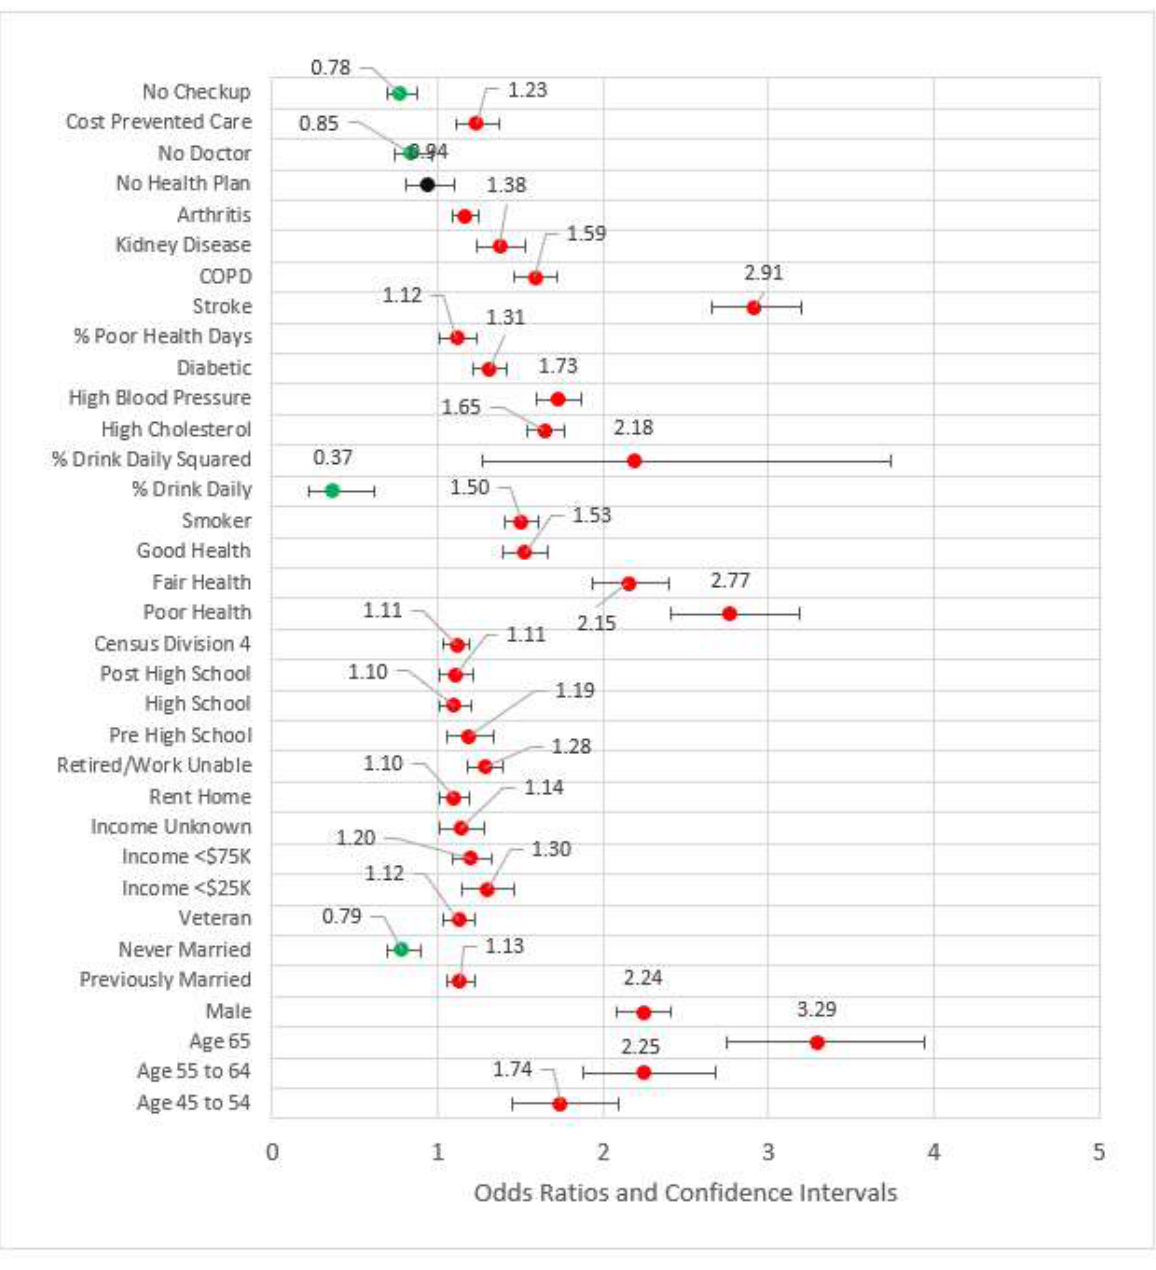
Figure 5. Forest plot of Model 5 (red = significant odds ratios greater than 1.0, green = significant odds ratios less than 1.0, black = not significant) .